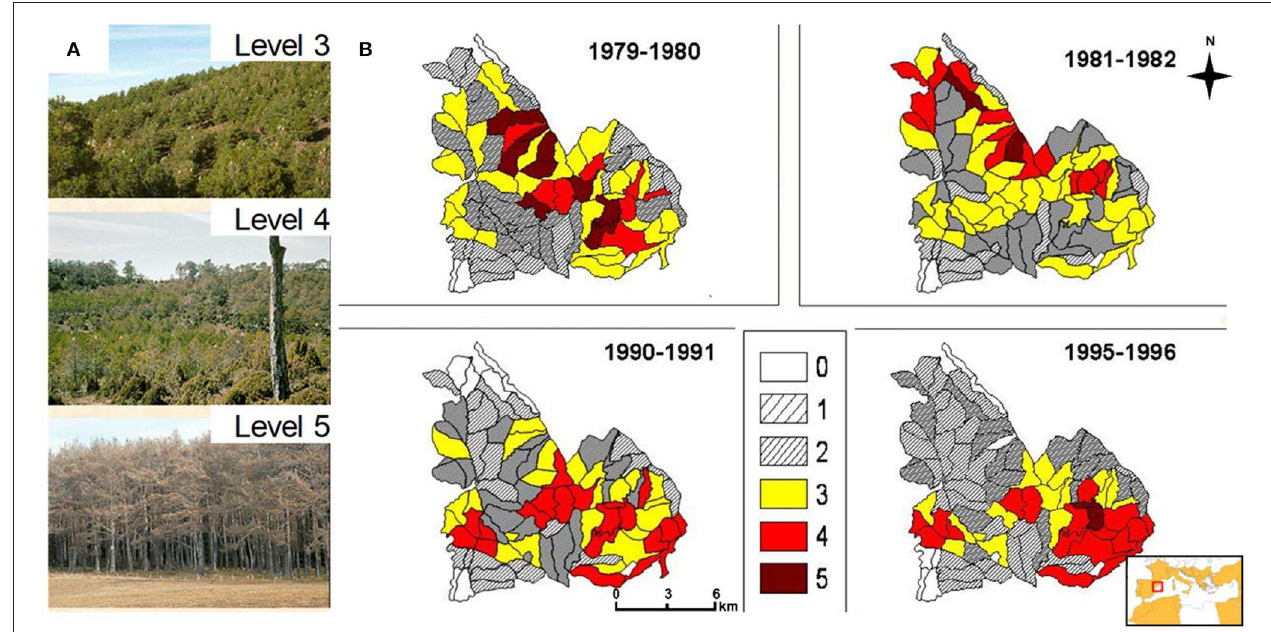
FIGURE 1 | Views of (A) pine processionary moth (PPM) defoliation levels 3, 4, and 5 used in the monitoring of the Mora de Rubielos study area (Teruel, Spain), (B) illustrative winters with different PPM defoliation levels (0–5, color scales). In the plot (B) the inset shows the location of the study area (box) and the Circum-mediterranean countries where T. pityocampa has been reported are colored (orange